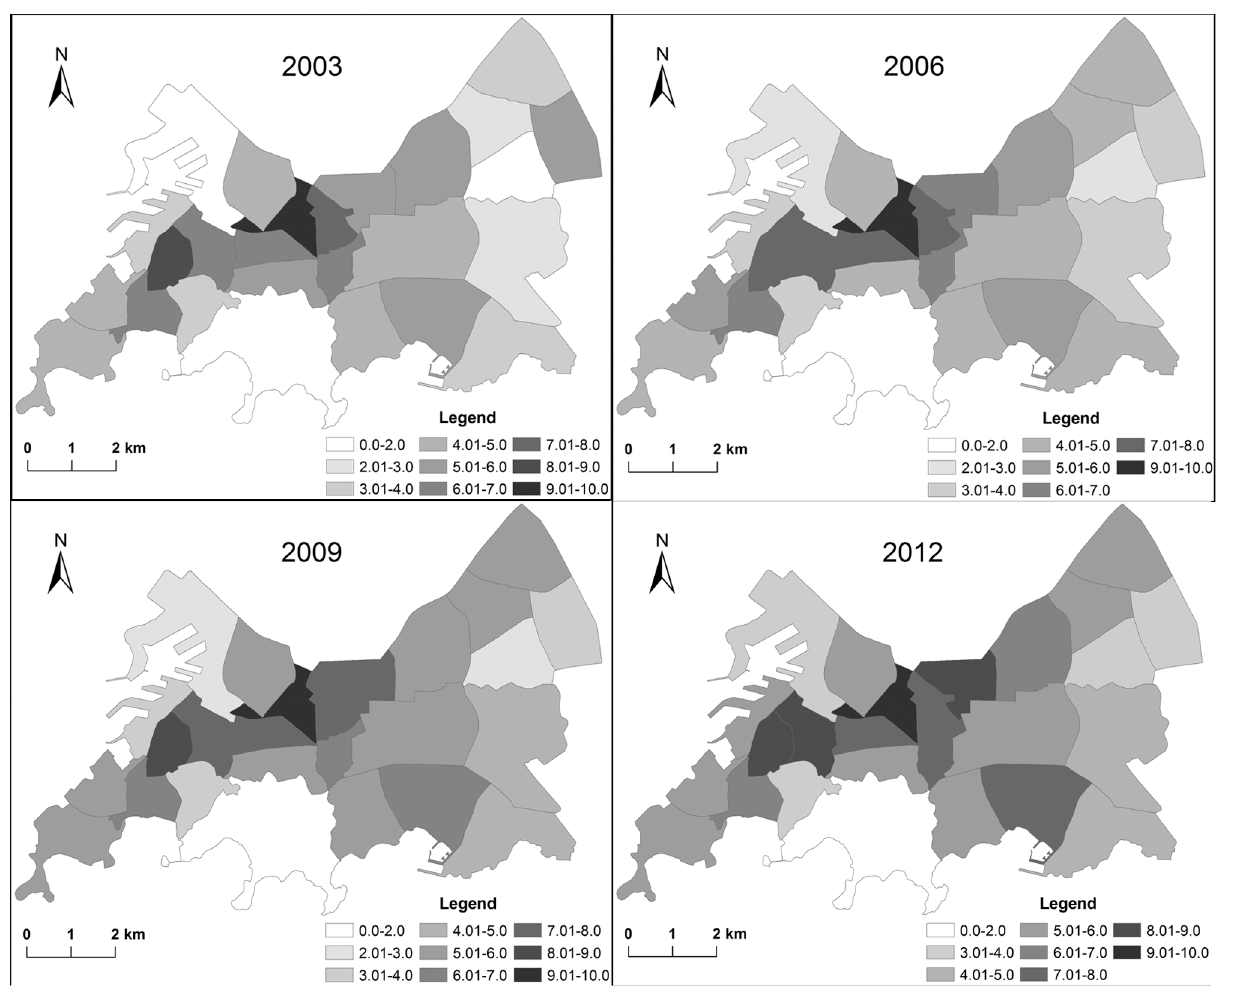
Fig 5. Characteristics of land use intensity (LUI) in the study